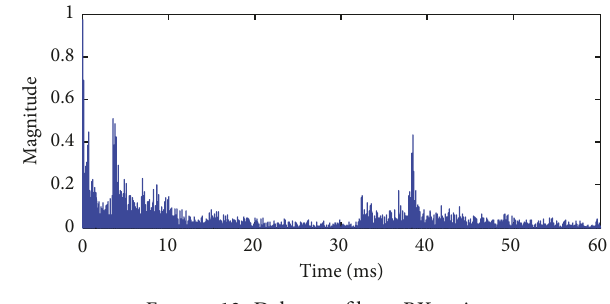
Figure 12: Delay profile at RX unit. Table 6: Experimental